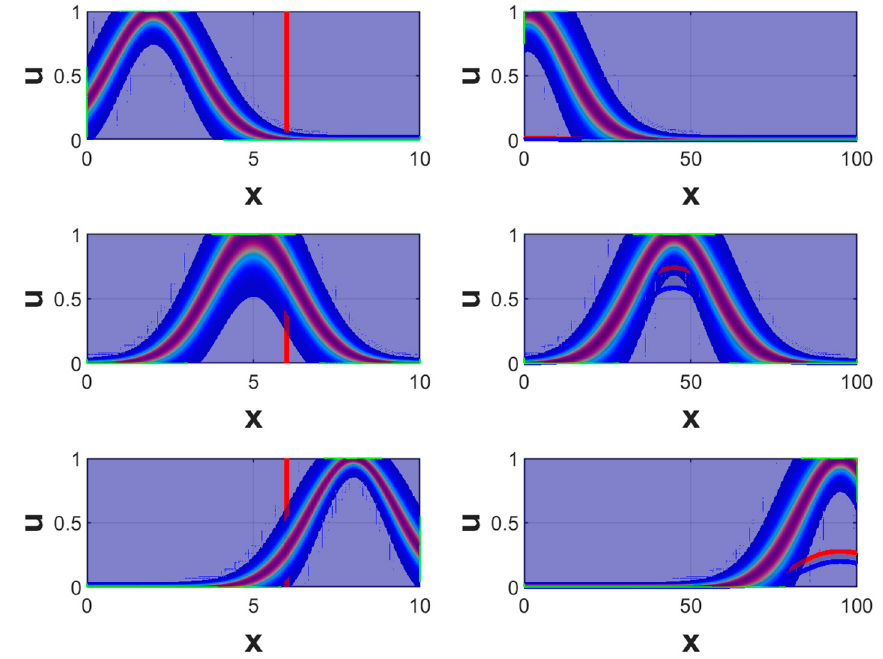
Figure 4. Illustration of the inference process for a value of x = 6.